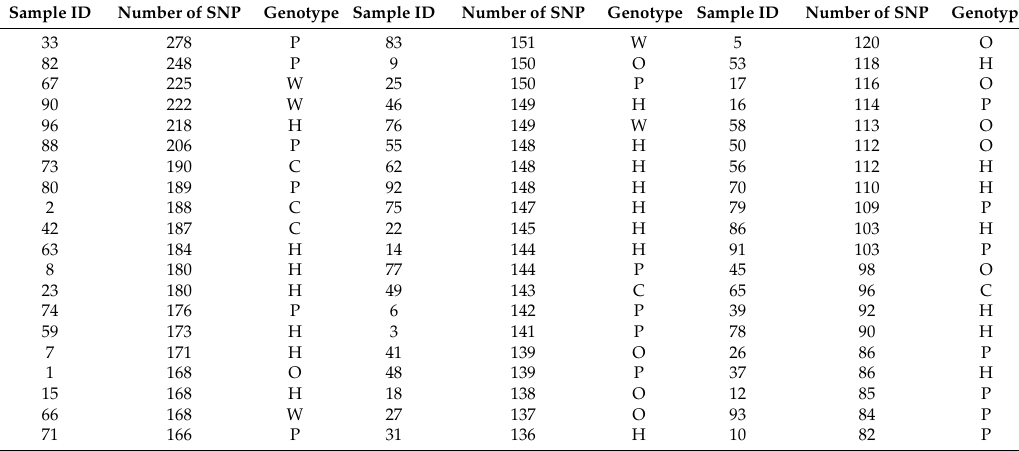
Table 1. The number of single nucleotide polymorphisms (SNPs), in decreasing order, detected across the 21 resistance gene analogs (RGAs) in 96 beet